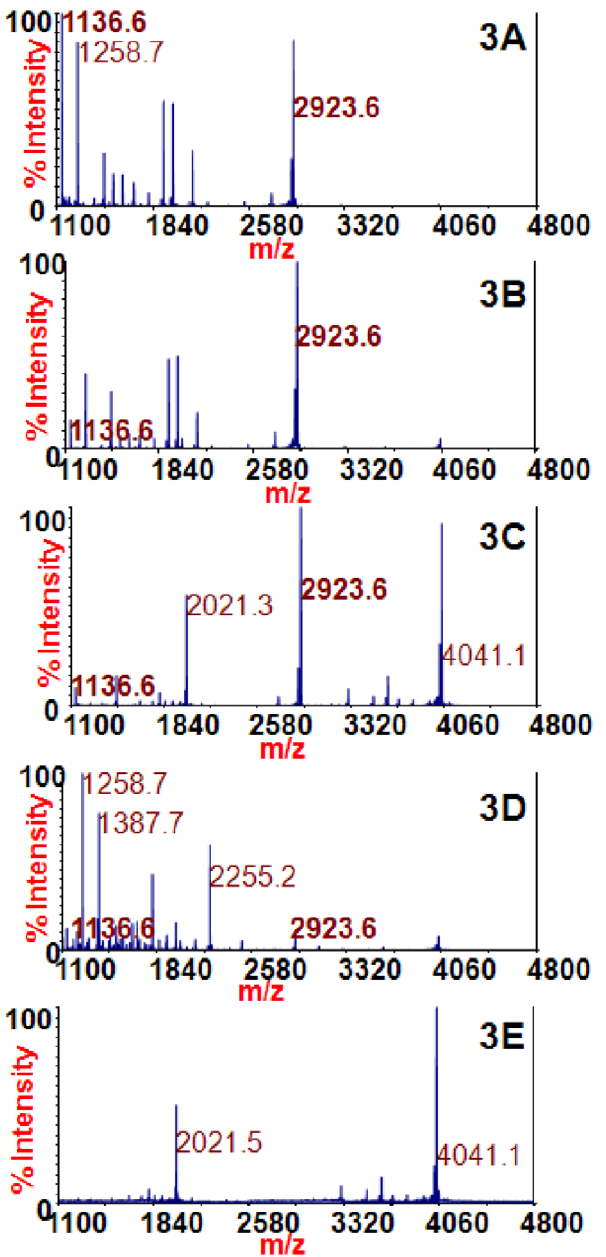
Figure 3. Mass spectra of the Endopep-MS BoNT/E reactions with /E1 (3A), /E2 (3B), /E3 (3C), /E4 (3D), or no toxin (3E) extracted using the 4E17.1 antibody-coated beads. The peptide cleavage products indicating BoNT/E are m/z 1136.6 and 2923.6 and the peptide substrate is present at m/z 4041.1.